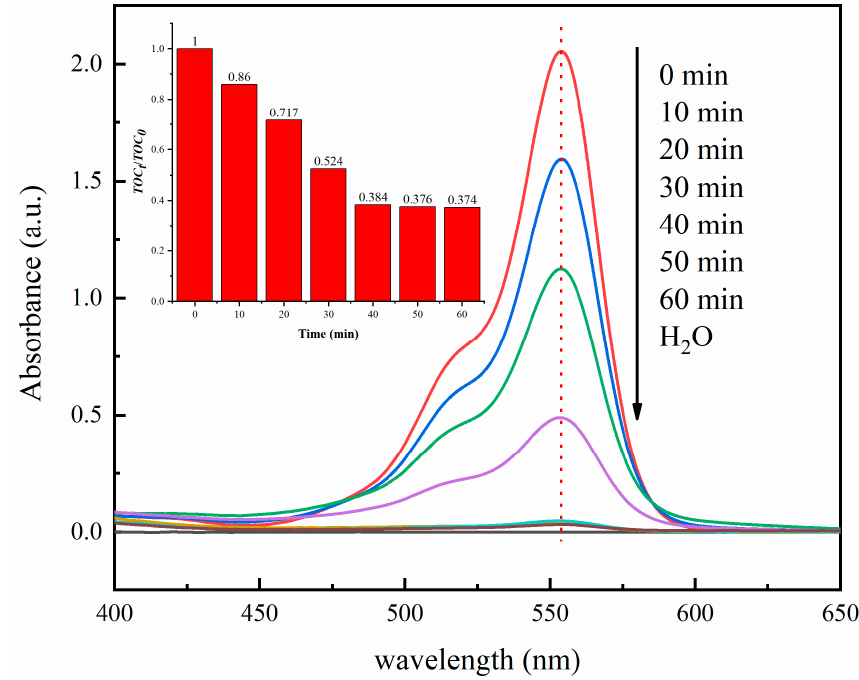
Figure 6. UV–Vis spectra of RhB solution during degradation process (the insert shows corresponding ration of ( TOC t / TOC 0 )).